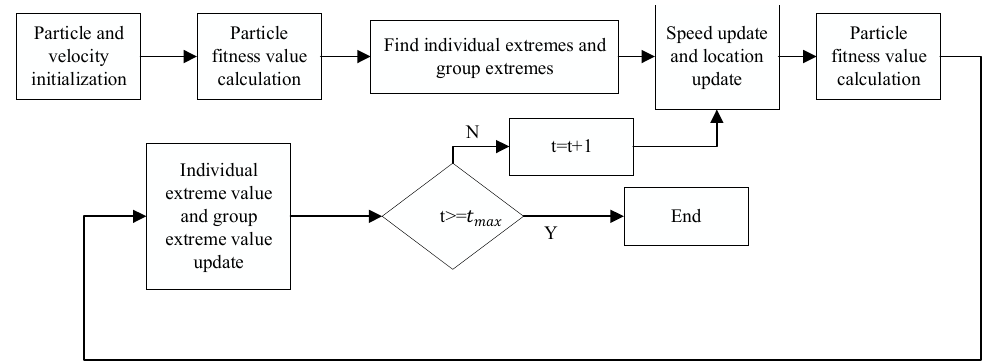
Figure 3. PSO algorithm flow chart.